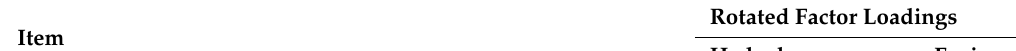
Table 4. Results of the Confirmatory Factor Analysis (Six Items) for Study 1 (Subsample 2: n =